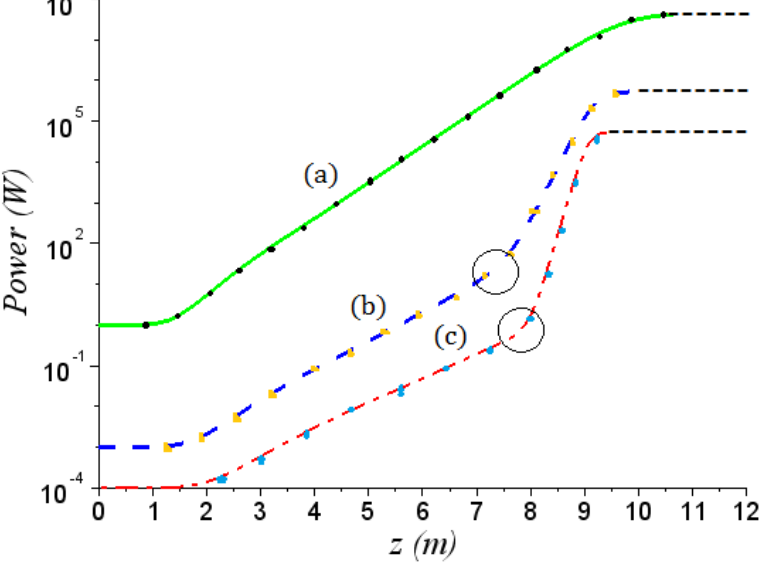
Figure 1. Harmonic power growth vs. the undulator length in m; ( a ) First Harmonic (green) ( b ) Third harmonic (blue) ( c ) Fifth harmonic (red). The encircled region around the inflection points, where the transition to the NLHG regime occurs, is not well reproduced by the analytical formulae. Linear and NLHG contributions are indeed summed incoherently, namely through the sum of two intensities ( Λ n ( z ) and Π n ( z ) ), without including the respective phases determining at that point an insignificant